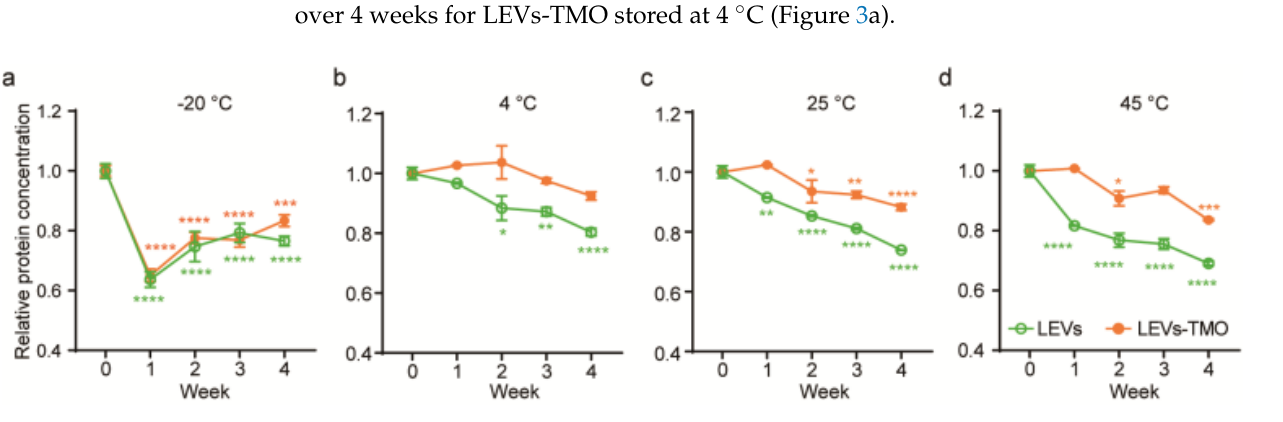
Figure 3. Total protein concentrations associated with LEVs stored with and without preservatives at different temperatures. The relative protein concentrations of LEVs and LEVs-TMO stored at ( a ) − 20, ( b ) 4, ( c ) 25, and ( d ) 45 °C for 4 weeks were detected by BCA. Data are presented as mean ± standard error of mean (SEM) (* p < 0.05, ** p < 0.01, *** p < 0.001, **** p < 0.0001).